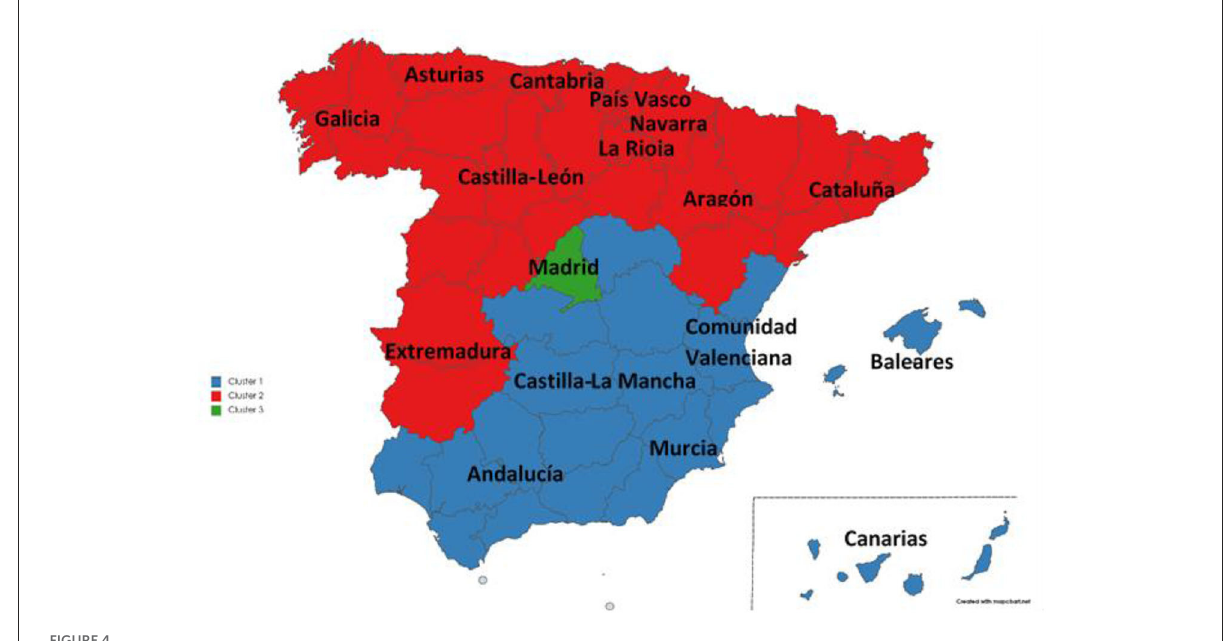
FIGURE4 Spanish map of clusters.